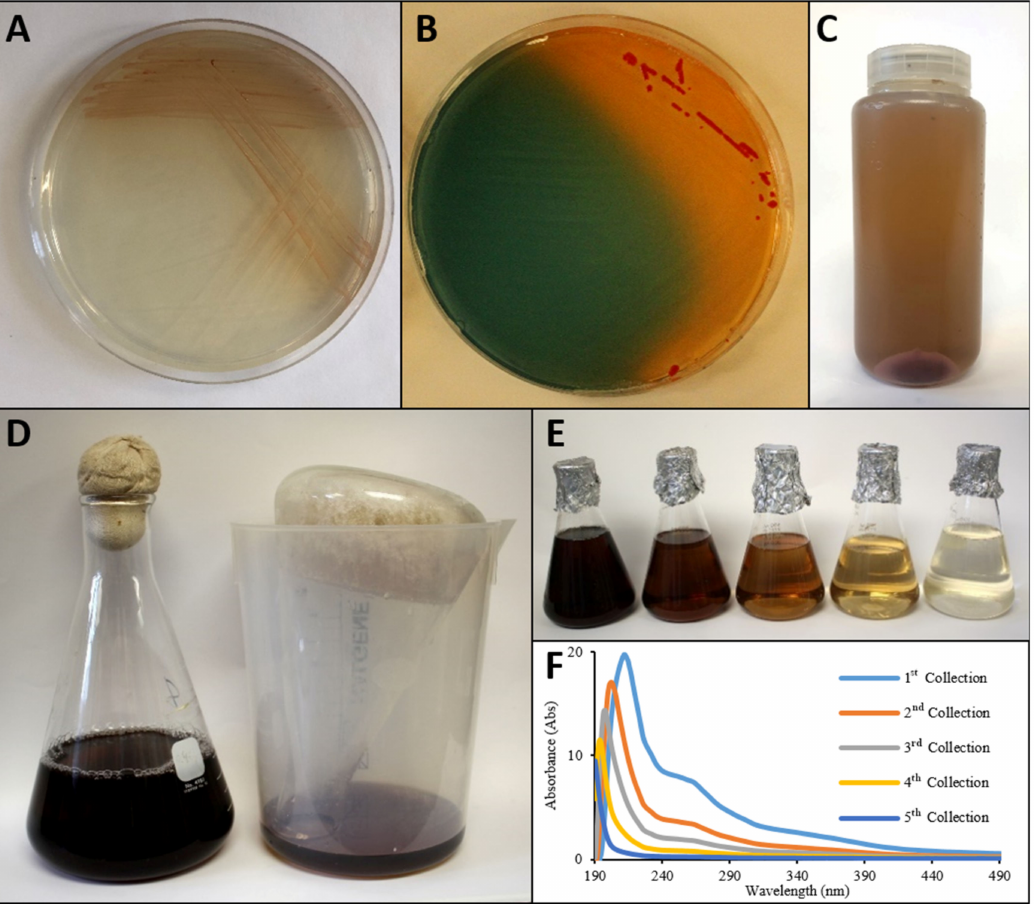
Figure 1. Extraction and concentration of brown pigment excreted by C. halotolerans . ( A ) Strain EG19 released a brown pigment into MA medium. ( B ) Fe-CAS plate with siderophore production by EG19. ( C ) Pelleted cells under supernatant. ( D ) Pigment concentrated with freezing-out technique. ( E ) Collected fractions during thawing with concentrated pigment released first. ( F ) Absorbance spectrum of each